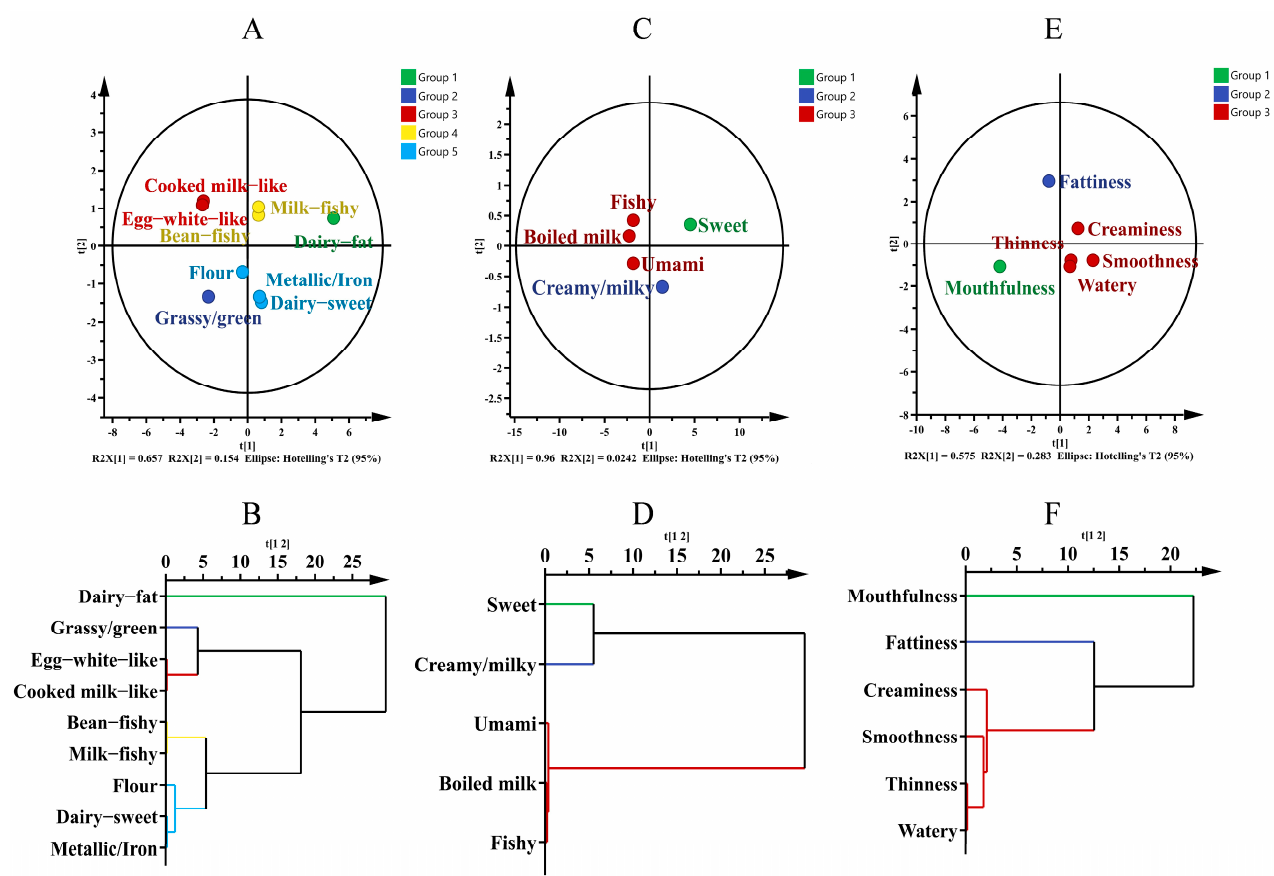
Figure 2. Principal component analysis (PCA) and hierarchical cluster analysis (HCA) of the sensory profile descriptors of human milk. ( A , B ) aroma, ( C , D ) flavor, ( E , F )